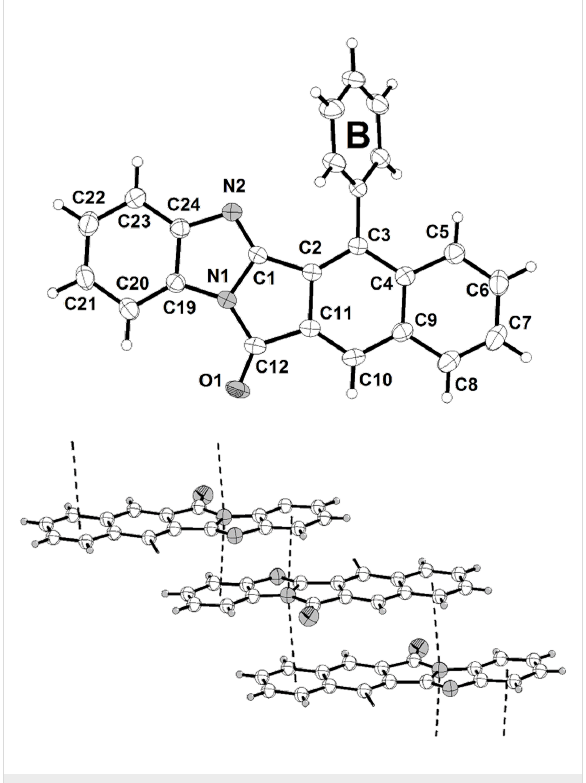
Figure 3: The ORTEP-type plot of the asymmetric unit of the crystal structure 6 (top) and π -stacking interactions (bottom) (ellipsoids are drawn at the 40% probability